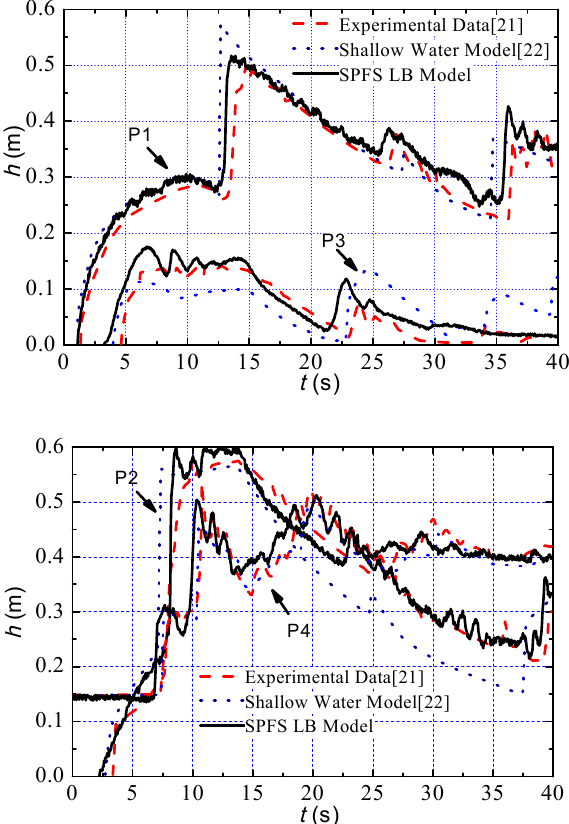
Figure 8. Water surface time series of measuring point.